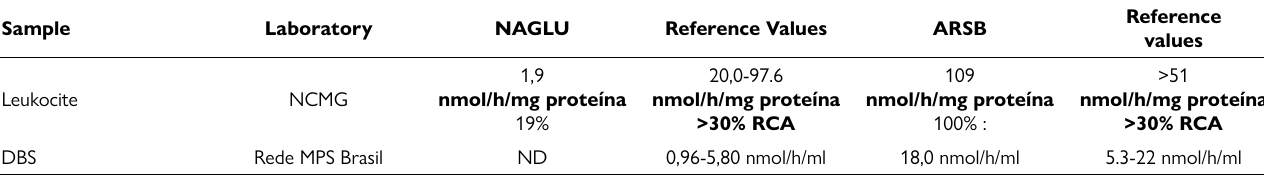
Table 1. Result of the NAGLU and ARSB activity enzymes of the patient. Sample